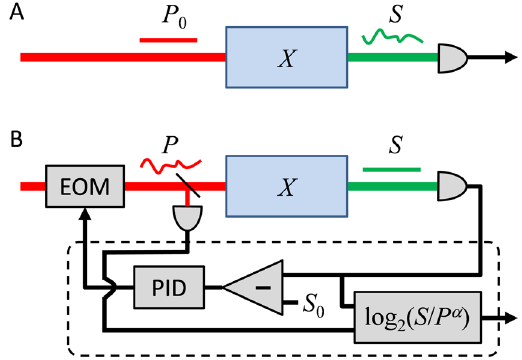
Figure 1. Schematic of principle. Layout for ( A ) conventional, and ( B ) active-illumination-assisted multiphoton microscopy (PID = proportional-integral-derivative